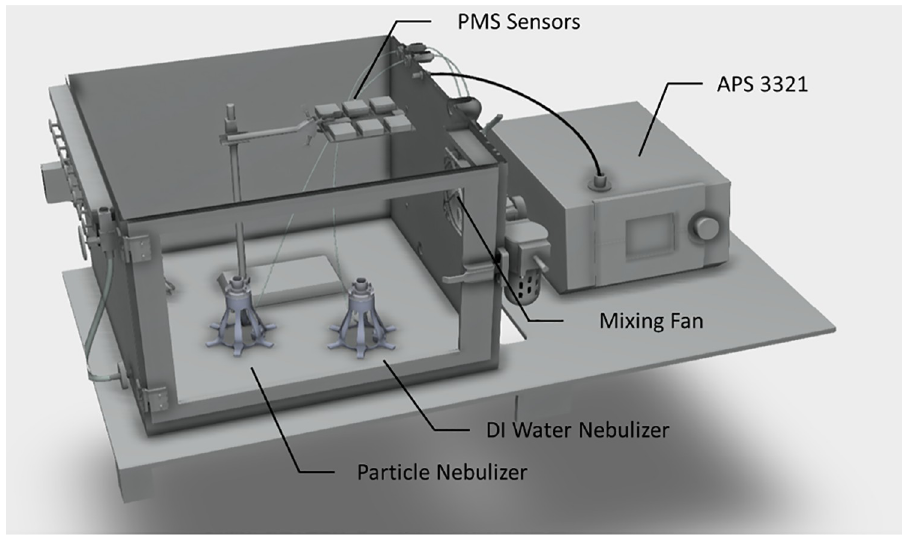
Fig 2. A 3D view of the experimental setup.